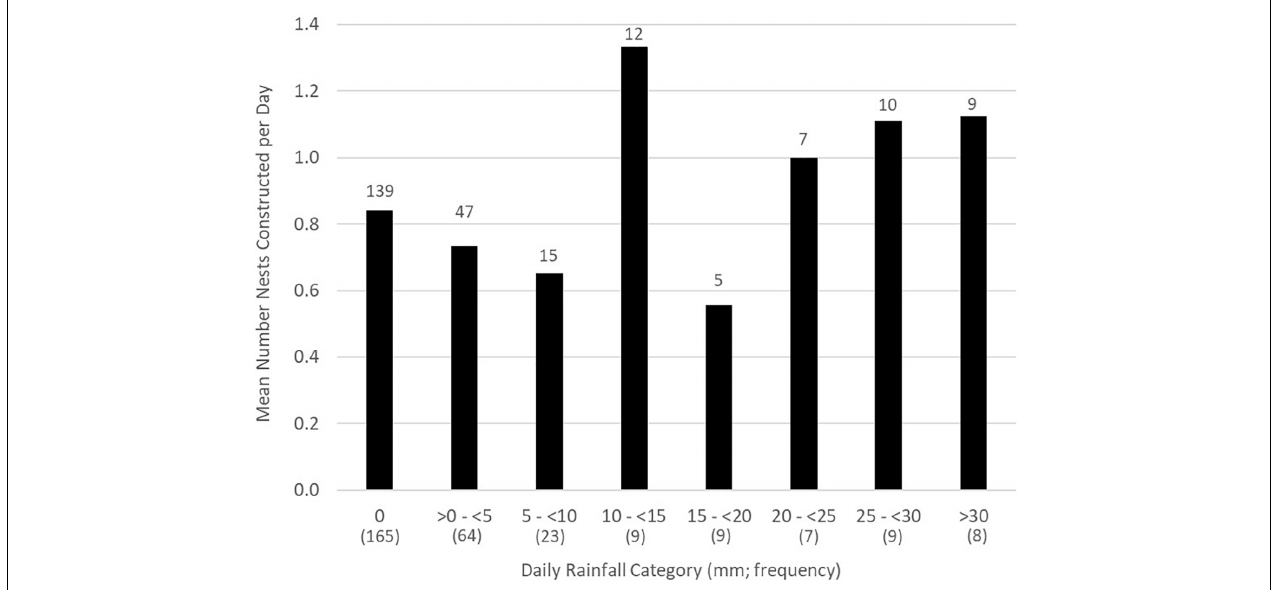
FIGURE 1 | All-year mean number of Graptemys ouachitensis nests constructed/d by daily rainfall category along the Wisconsin River, WI, United States, during 12 study years from 2008 to 2021 ( n = 244 nests). Overall number of nests per rainfall category appear above each bar; number of days within each category appear below, in